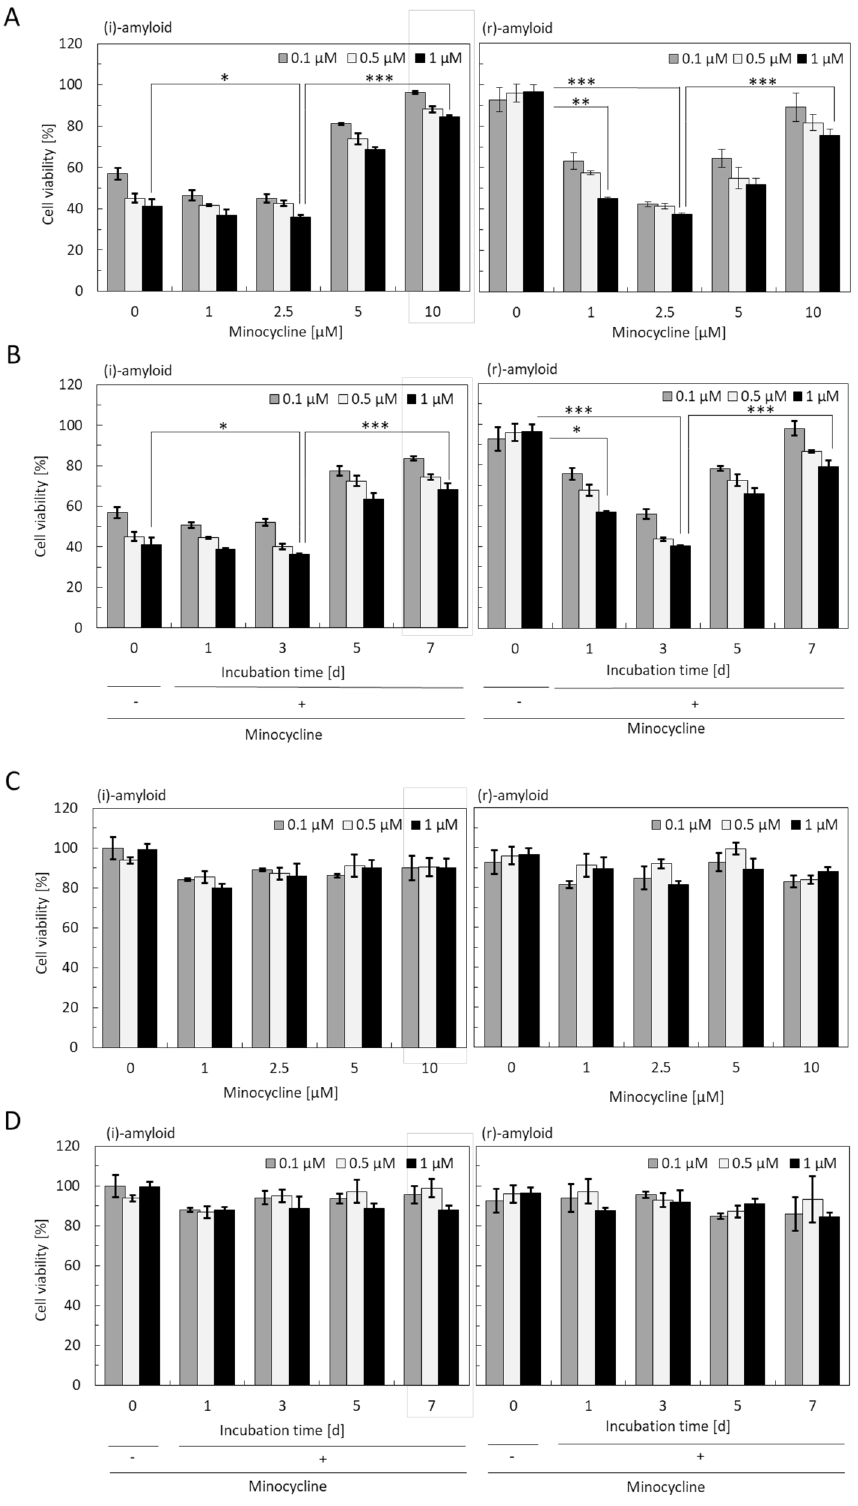
Figure 2. Cytotoxicity of the insulin amyloid samples in precipitate and supernatant using MTT assay against HeLa cells. Samples in the precipitate ( A ) and the supernatant ( C ) are (i)-amyloid (left) and (r)-amyloid (right) incubated with minocycline for 1 week at the indicated concentrations and centrifuged at 15,000 rpm for 15 min. Samples in the precipitate ( B ) and the supernatant ( D ) are (i)-amyloid (left) and (r)-amyloid (right) incubated with a fixed minocycline concentration (50 µM) for the indicated periods and centrifuged at 15,000 rpm for 15 min. Samples incubated without minocycline for 7 days were shown as controls [0 µM ( A , C ) and 0 day ( B , D )]. All samples were quantified by BCA assay and were diluted to the same protein concentration: 0.1, 0.5, and 1 μM (white, gray, and black, respectively). The absorbance was normalized for PBS as 100%. (*P < 0.05, **P < 0.01, ***P <